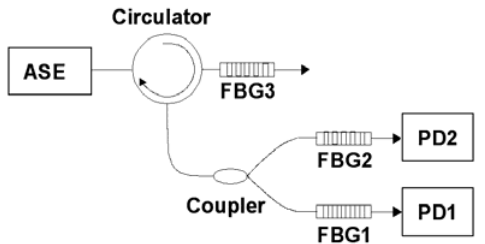
Figure 1. Scheme of the DP-FBG demodulation